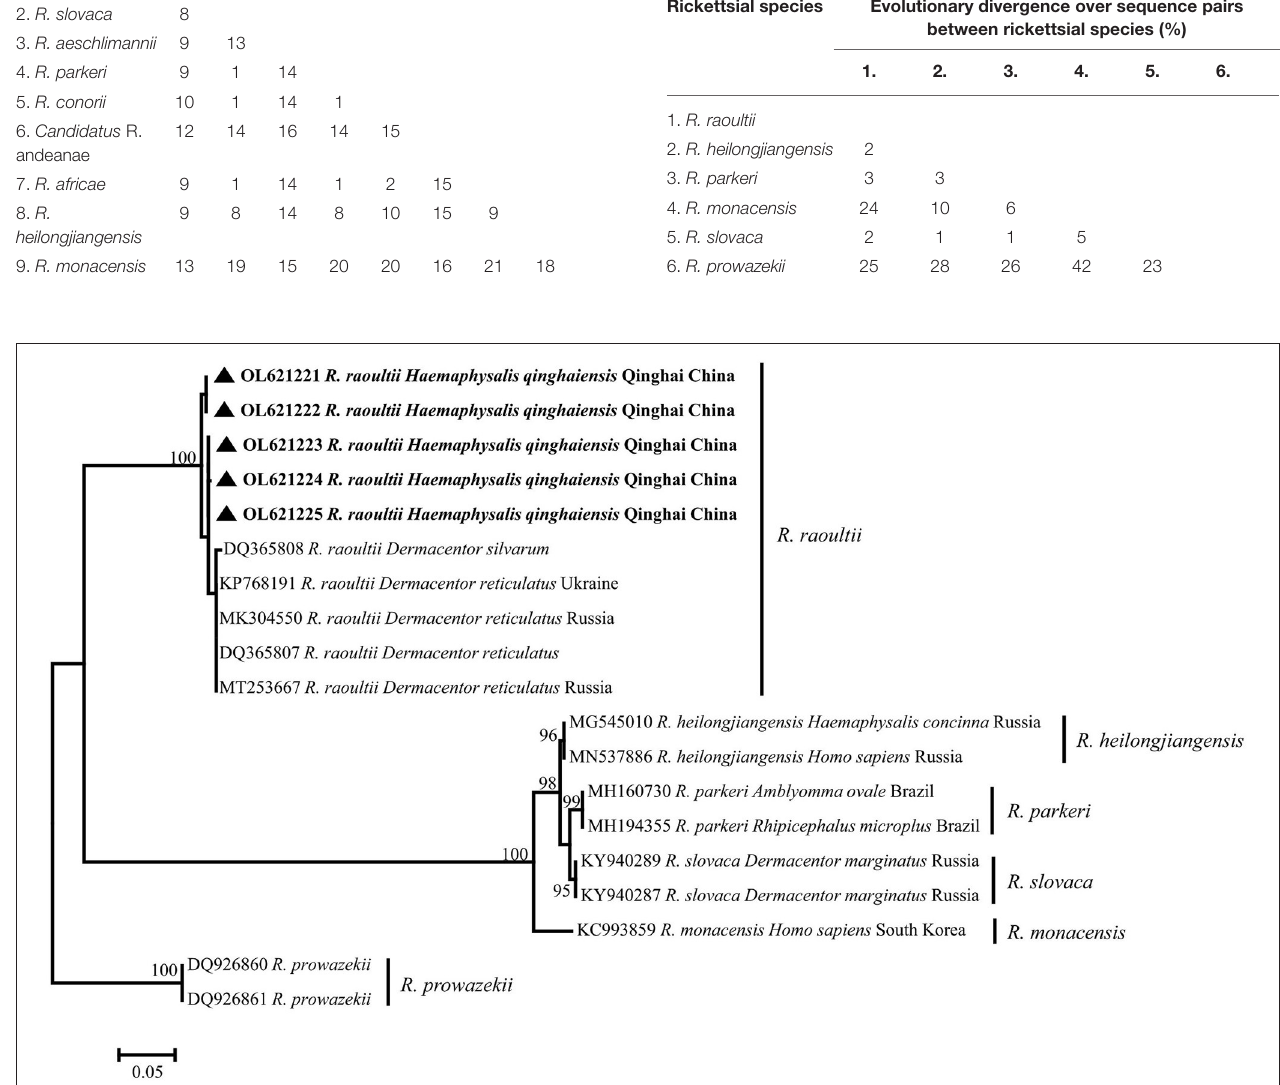
FIGURE 5 | Phylogenetic tree based on sca4 particle sequences (624 bp) of spotted fever group (SFG) Rickettsia obtained in this study. Bootstraps analysis was performed with 500 replicates. The solid triangle indicates sequences from Haemaphysalis qinghaiensis . All sequences from this study are bolded.